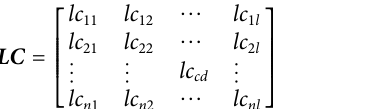
TABLE 2 | Customers ’ economic losses caused by the sag. Business